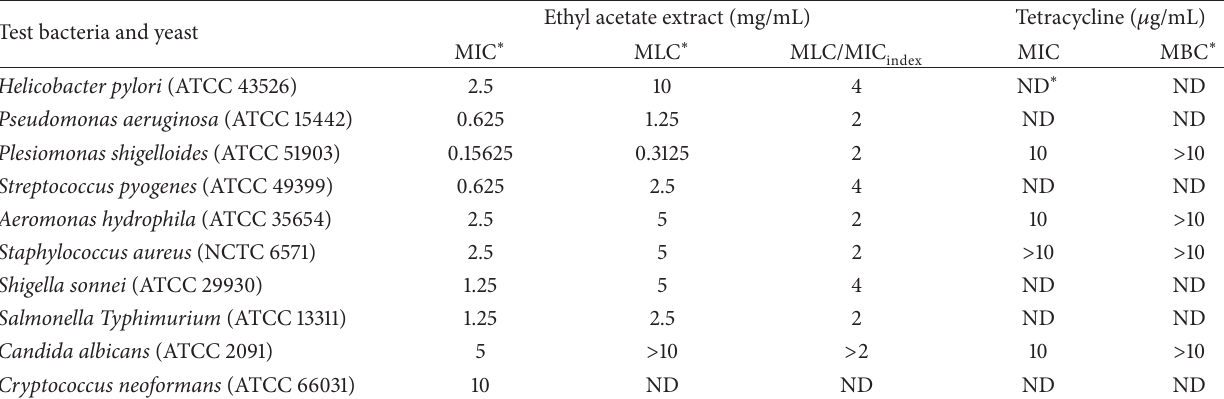
of the extract against test index